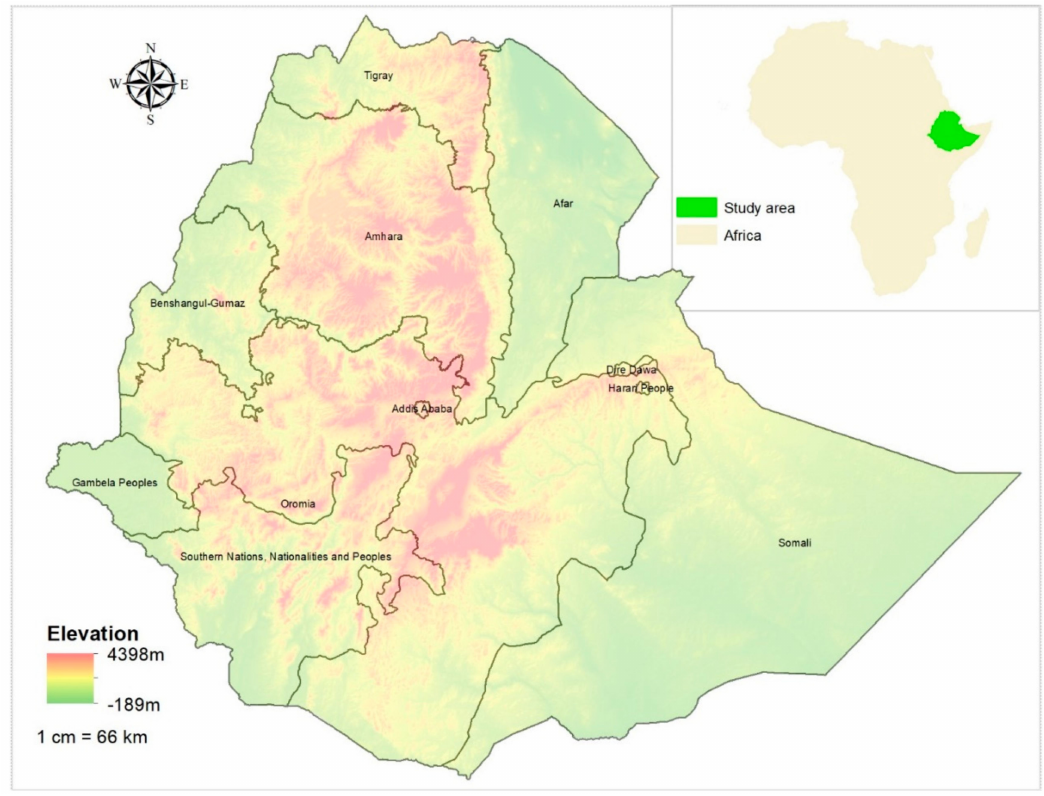
Figure 1. A map of the study area (Ethiopia and regions) depicting changes in elevation derived from a 30 m digital elevation model (DEM; Source http: // www.worldclim.org /